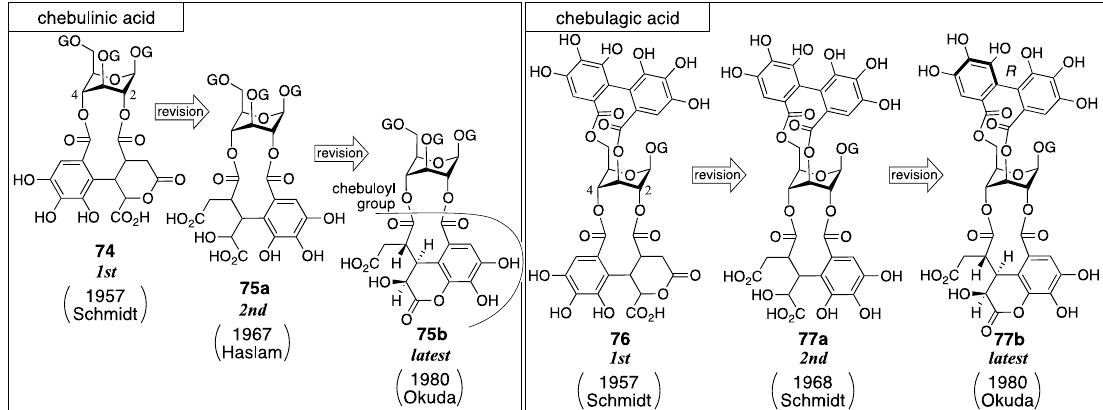
Figure 30. The transition of the structures of chebulinic acid and chebulagic acid.